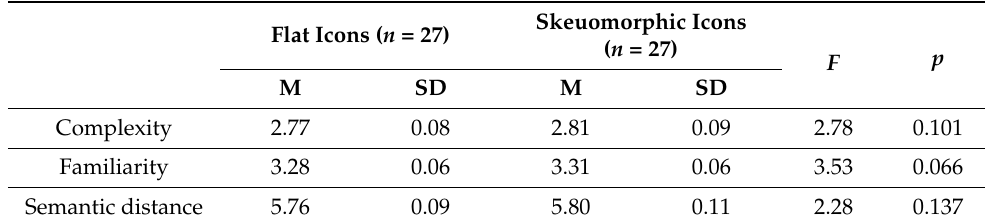
Table 1. Mean scores and standard deviation for icon complexity, familiarity, and semantic